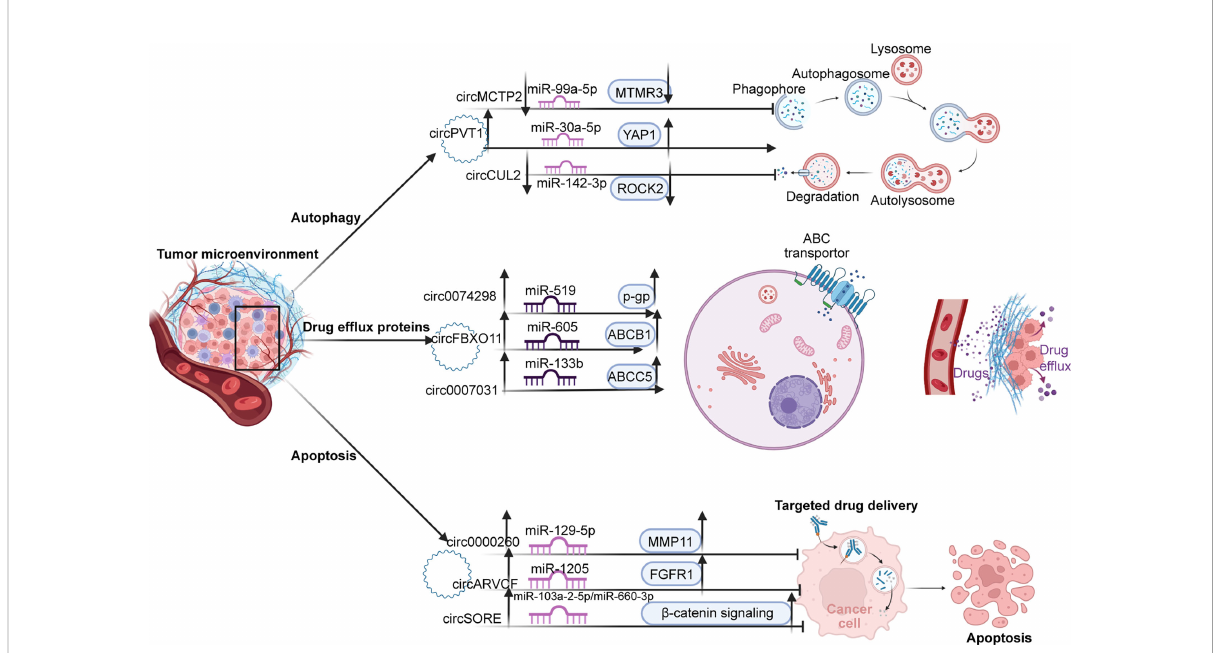
FIGURE 4 There are three main pathways of resistance to TME. First, by promoting autophagy; upregulated circPVT1 promotes autophagosome formation through the mir-99a-5p/MTMR3 axis. In contrast, cirMCTP2 and cricCUL2, as tumor suppressors, inhibit autophagy through downregulated MTMR3 and ROCK2 expression, respectively. Second, by regulating the expression of drug excretion proteins, circ0074298, circFBXC11, and circ0007031 promote the excretion of chemotherapy drugs from cells by promoting the expression of p-GP, ABCB1, and ABCC5 proteins, respectively. Thirdly, by inhibiting apoptosis. Circ0000260, circARVCF, and circSORE inhibit drug-induced apoptosis by activating the MMP11, FGFR1, and b -catenin pathways, resulting in drug